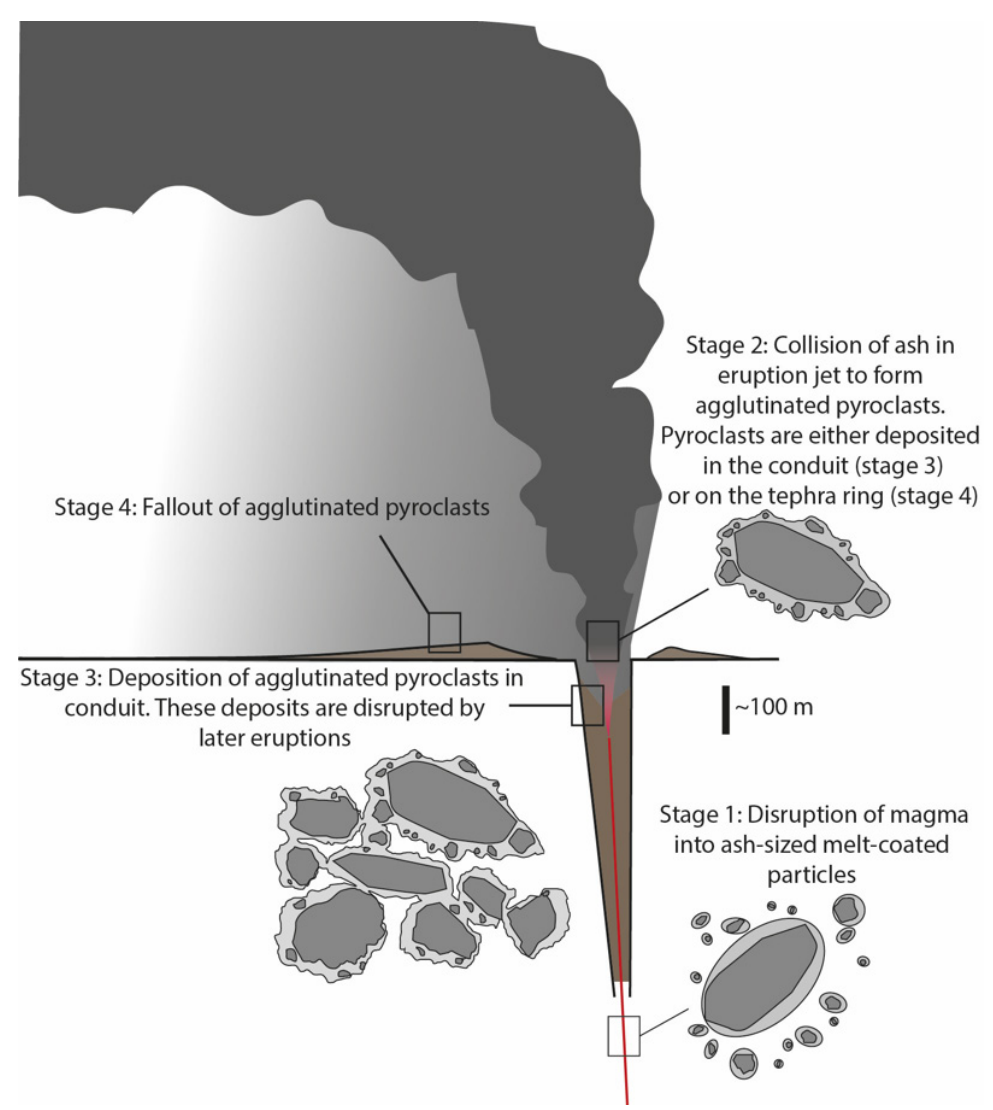
Figure 7: Genesis of agglutinated pyroclasts. Ascending magma is fragmented into ash-sized particles (stage 1) which then collide to form agglutinated pyroclasts (stage 2). These then either fallout in the conduit to form a porous agglutinated deposit (stage 3), or are dispersed by the eruption plume across the tephra ring (stage 4). Conduit deposits are disrupted by subsequent eruptions and fragments are entrained into the plume and deposited in the surrounding tephra ring. Scale bar refers to the volcanic plumbing system and edifice, not the